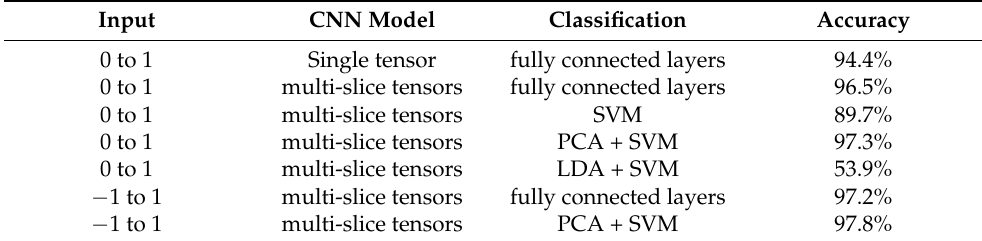
Table 2. The comparison of CNN